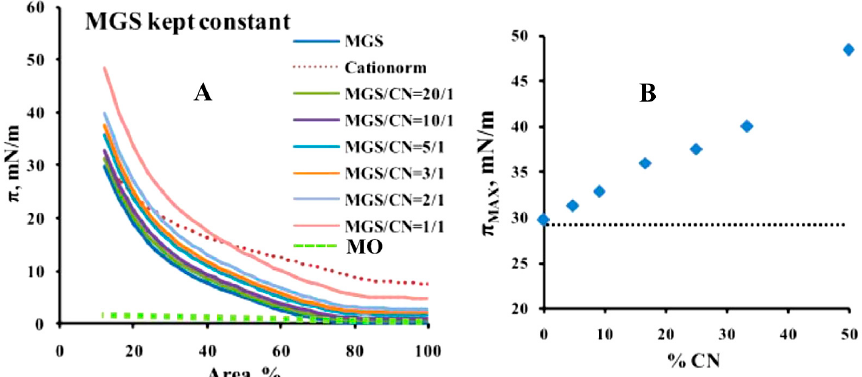
Figure 1. ( A ) Surface pressure area isotherms of MGS/CN pseudobinary films obtained at fixed MGS amount (i.e., the inclusion of CN increased the total lipid amount at the interface). The green dashed line shows the lack of surface activity by 30 µg of mineral oil (MO) mixture, consisting of light and heavy mineral oil in 1/1 ratio; ( B ) Dependence (blue rhombs) of maximum surface pressure, π MAX , on CN content at fixed MGS amount (the dashed line shows the lack of effect of MO on π MAX ).